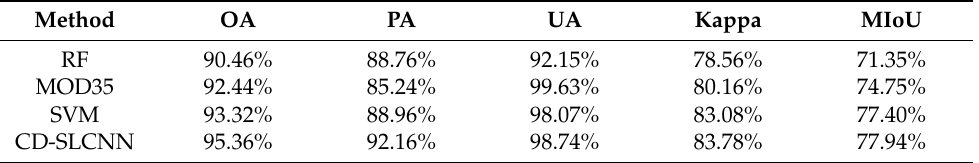
Table 2. Quantitative analysis of the CD-SLCNN results of MODIS data.